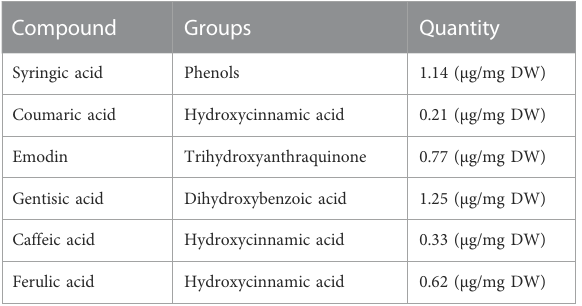
TABLE 3 Compounds identi fi ed in methanolic extract of Plumeria obtusa L. using HPLC-DAD.